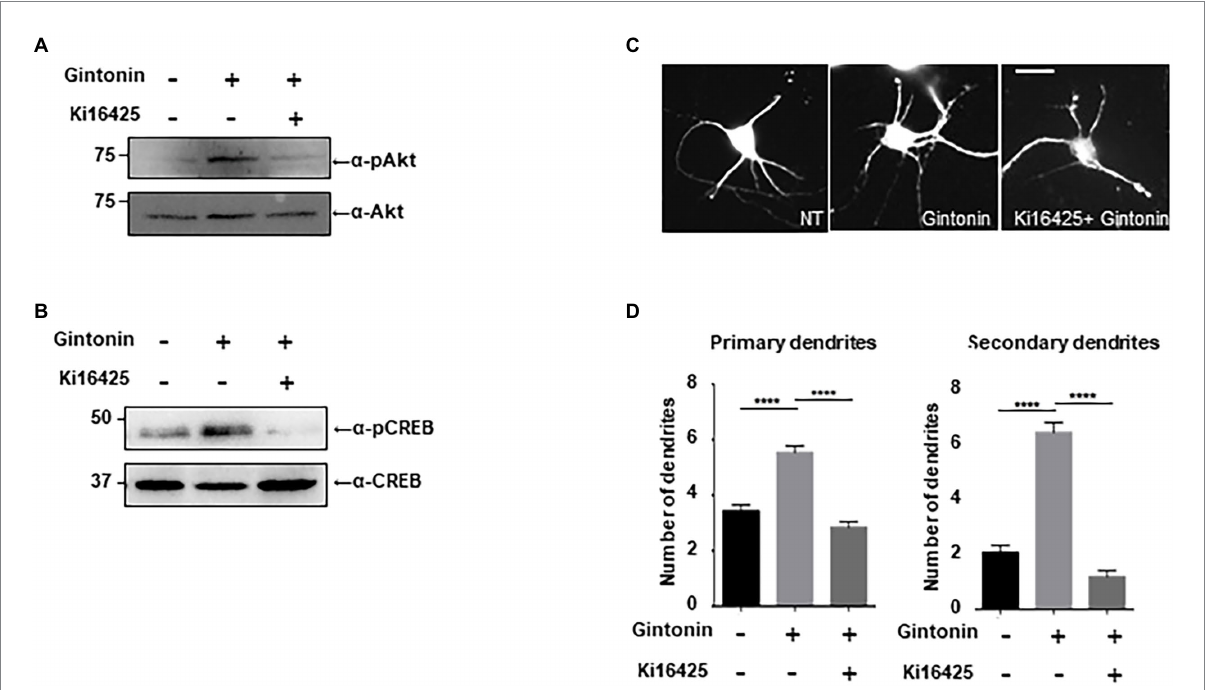
FIGURE 4 Gintonin-induced Akt/CREB activation and dendritic growth are abolished by LPAR inhibition with Ki16425. (A,B) Representative blots showing the effect of Ki16525 on gintonin-induced Akt and CREB phosphorylation. DIV7 cortical neurons were pretreated with 1uM Ki16425 for 1 h before administration of 3 μ g/ml gintonin for 2 h. Lysates were used for immunoblot analysis of phospho-Akt, Akt, phospho-CREB, and CREB. (C) Representative images of gintonin-treated and Ki16525-cotreated striatal neurons. Cultured striatal neurons were treated with 3 μ g/ml of gintonin in the presence and absence of 0.5 uM Ki16425 at DIV2. After 5 days of exposure, the cultures were fixed and stained with anti-MAP2 antibody. Neuronal processes were counted with fluorescent microscopy. Scale bar, 2 μ m (D) Quantitation of the number of primary and secondary dendrites is shown in (C) . Results are presented as means ± SEM from three independent experiments determined from the analysis of 40 neurons per condition per experiment (*** p < 0.0005, **** p < 0.0001, Student’s t